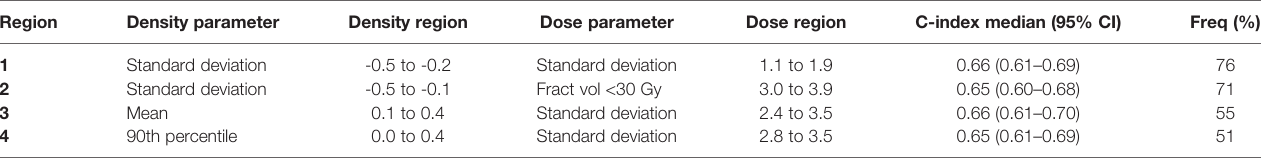
TABLE 2 | The models selected after assessment of region size, variance, stability, and model performance. Region Density parameter Density region Dose